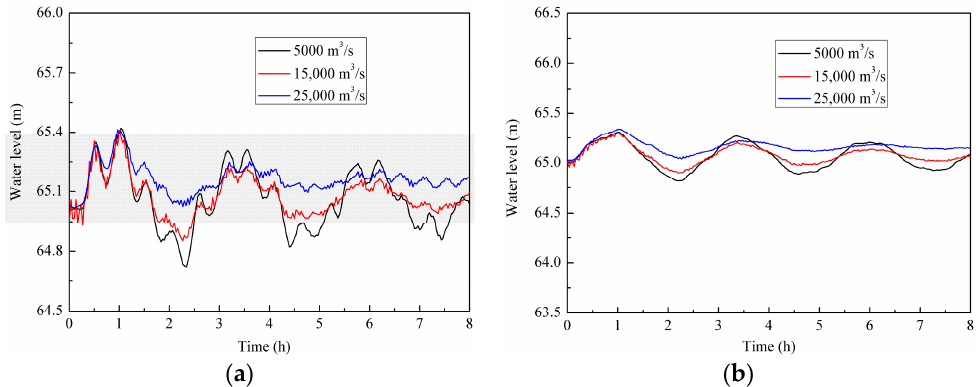
Figure 8. Water level variation process with the base flow. ( a ) Lower lock head of the ship lift; ( b ) Approach channel.